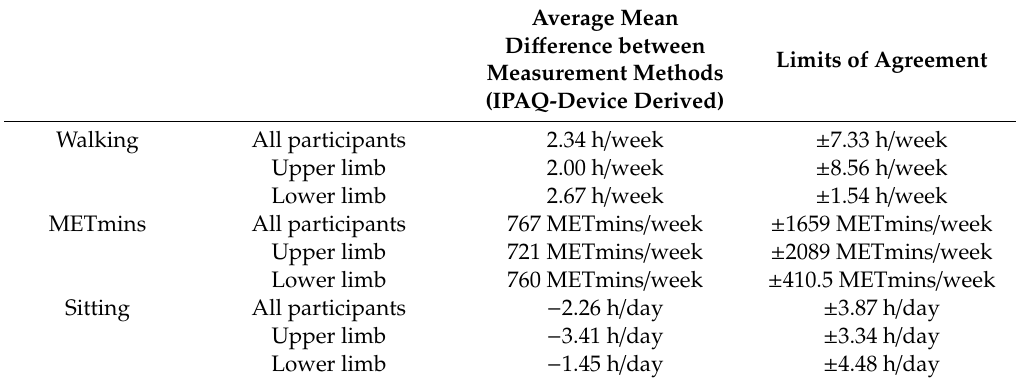
Table 3. Average mean di ff erence (over / under-estimation) between the International Physical Activity Questionnaire–Short Form and device measured physical activity and sitting time.